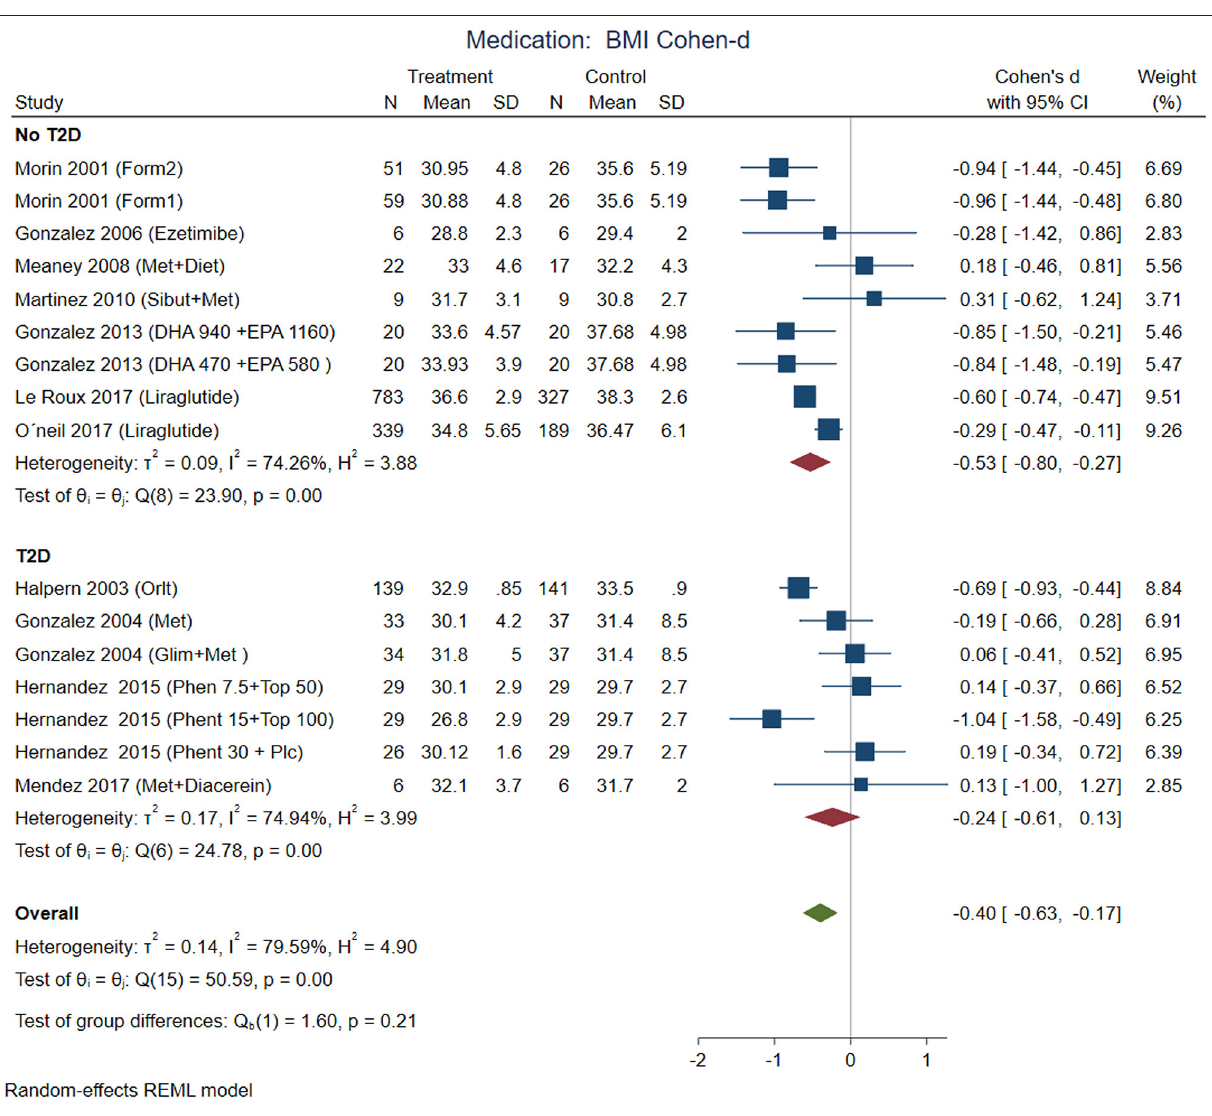
and Baja California. Table 1